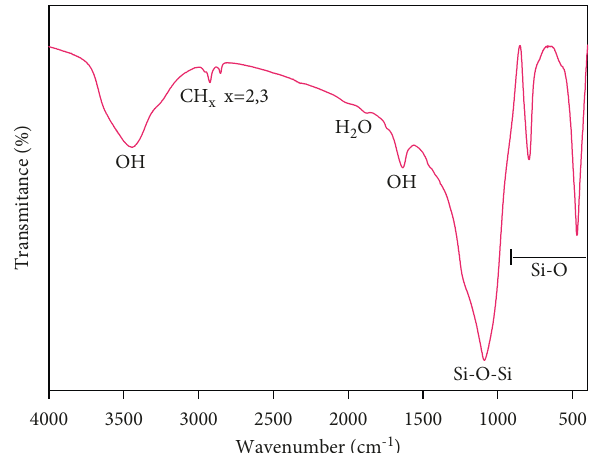
Figure 5: FTIR representative spectra profile of opal samples from Delanta district taken from mining site